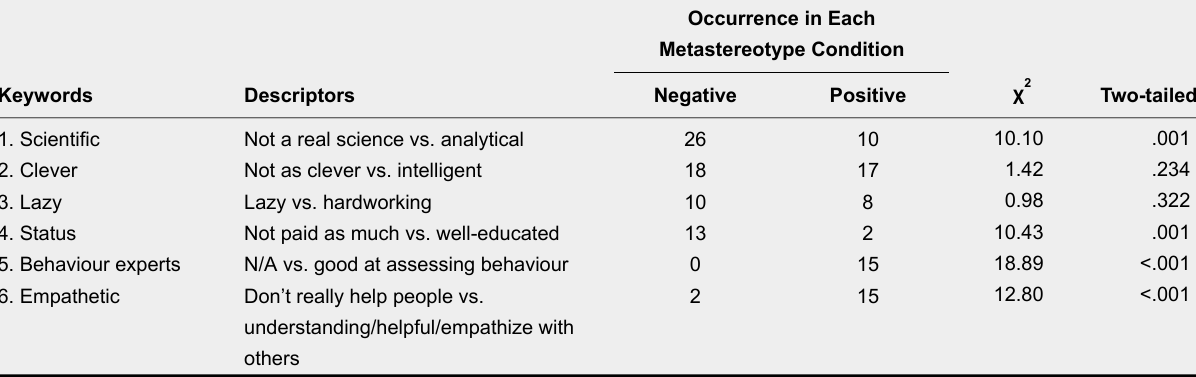
Analysis of Keywords Extracted from Participants’ Metastereotypes in Study